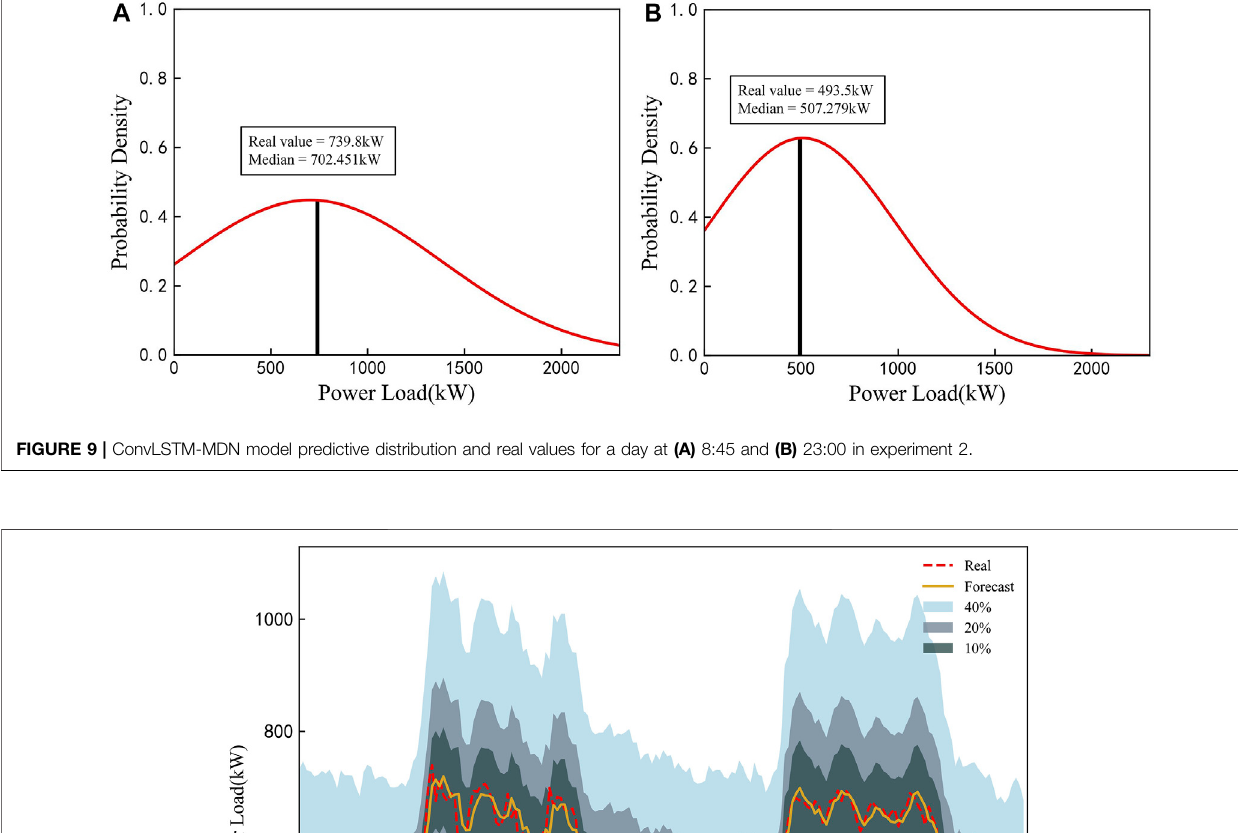
Figure 6B almost coincides with the peak, which indicates that the sharpness of predicted PDF is clear.